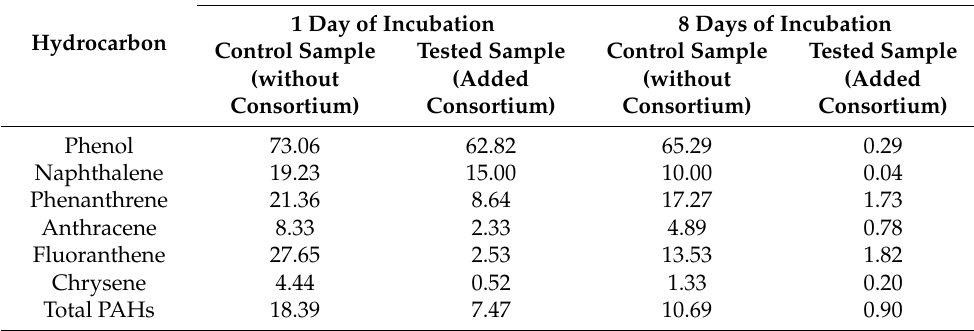
Table 2. PAHs and phenol content in the samples after: (a) 1 day, (b) 8 days of incubation as a percentage of the calculated initial concentration of PAHs and